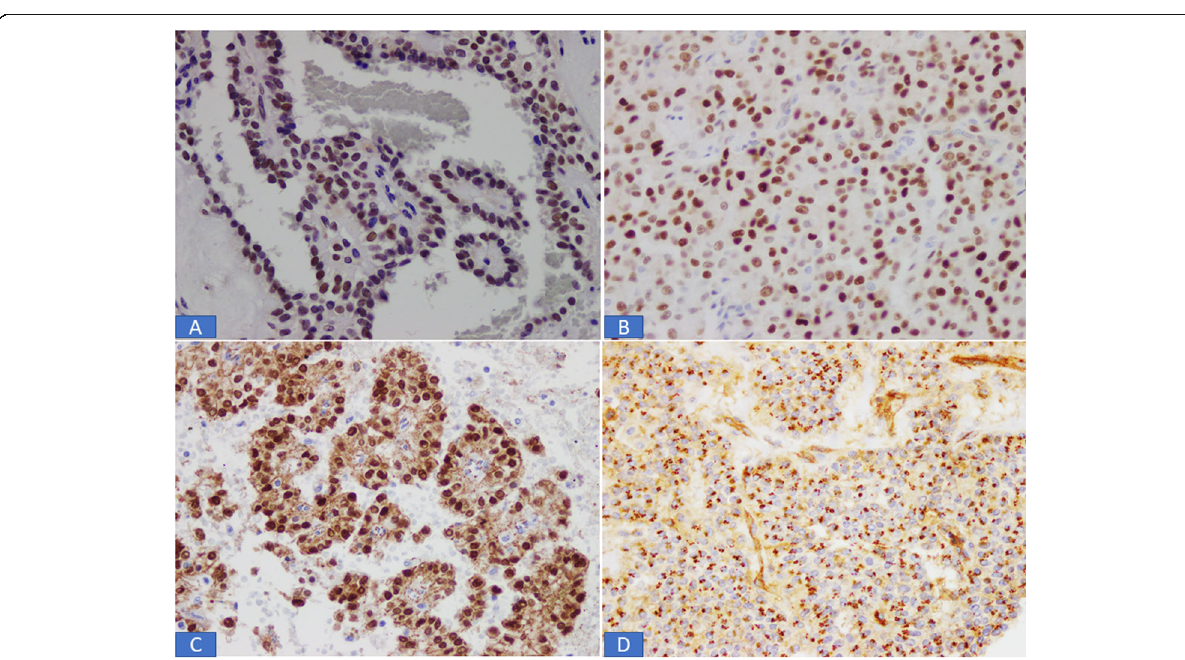
Fig. 4 Immunohistochemistry in SPN. a Nuclear positivity for TFE3 b Diffuse strong nuclear positivity for Cyclin D1 c Nuclear positivity for beta catenin d Cytoplasmic dot-like positivity for CD99 may demonstrate a unique staining pattern for diagnosis of